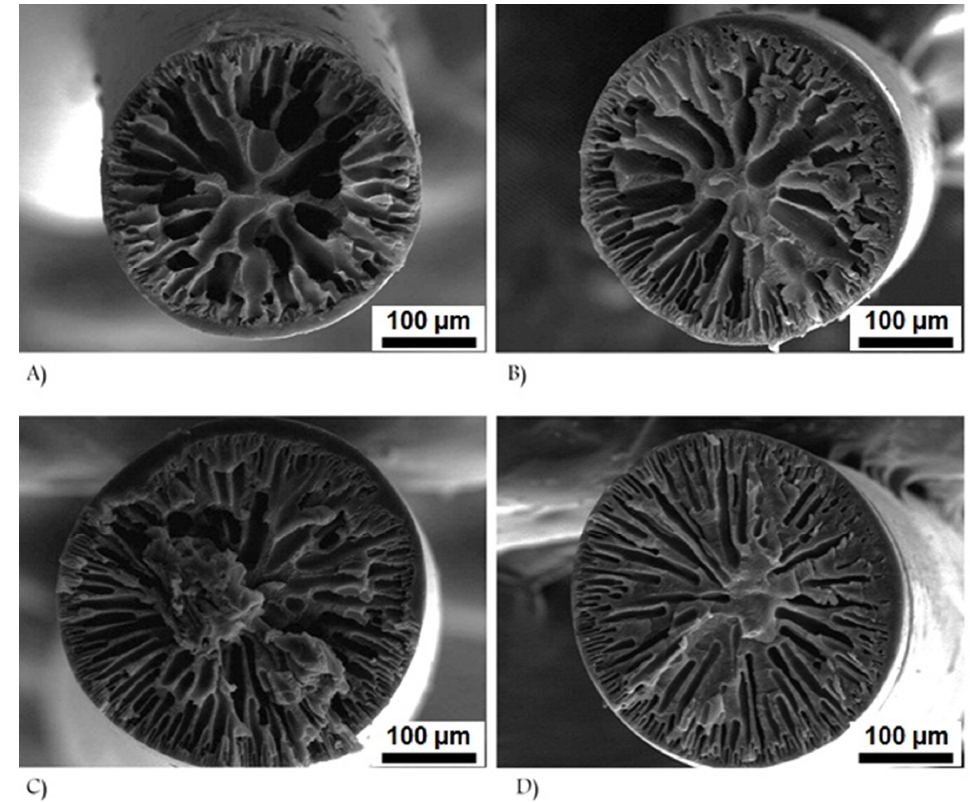
Figure 4. Effects of dope polymer concentration on cross-sectional morphology of as-spun PAN fibers: ( A ) 10 vol %, ( B ) 12 vol %, ( C ) 16 vol %, and ( D ) 20 vol % (reprinted with permission from [52] ; copyright 2008 John Wiley and Sons).